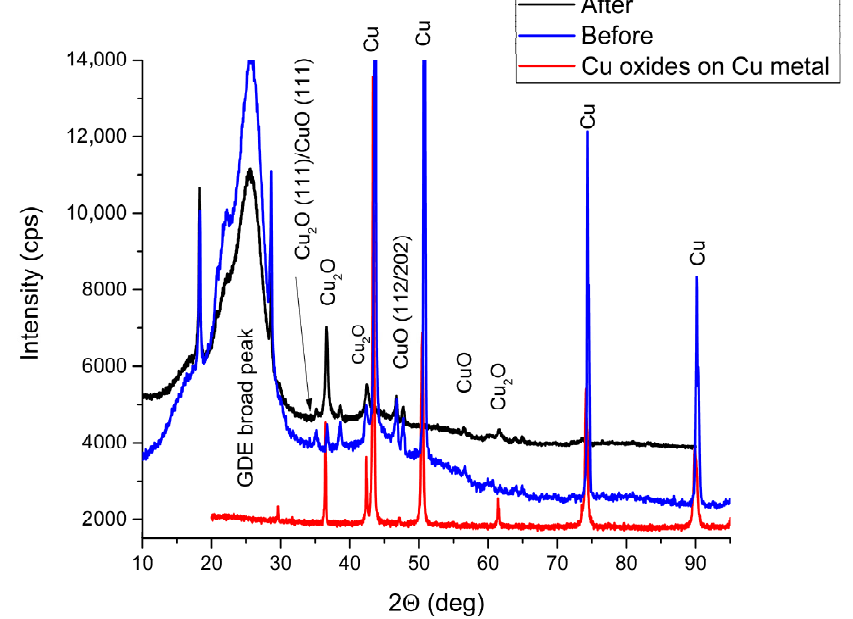
Figure 3. SEM pictures of electrodeposited copper catalyst layer with 0.3 mA/cm 2 short pulse (7 ms) current before and after 60 min electrolysis (in the pictures at the top and bottom, left and right is the same layer in two different magnifications, respectively scales 200 and 8 µm).